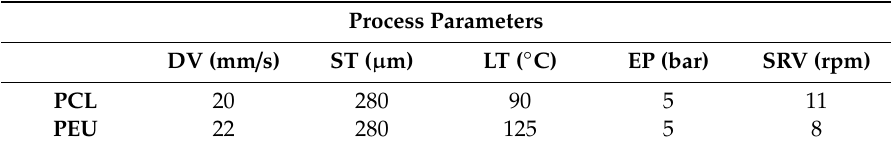
Table 1. Optimised set of process parameters used for the printing of PCL and PEU sca ff olds. Parameters are denoted as deposition velocity (DV), slice thickness (ST), liquefier temperature (LT), extrusion pressure (EP) and screw rotation velocity